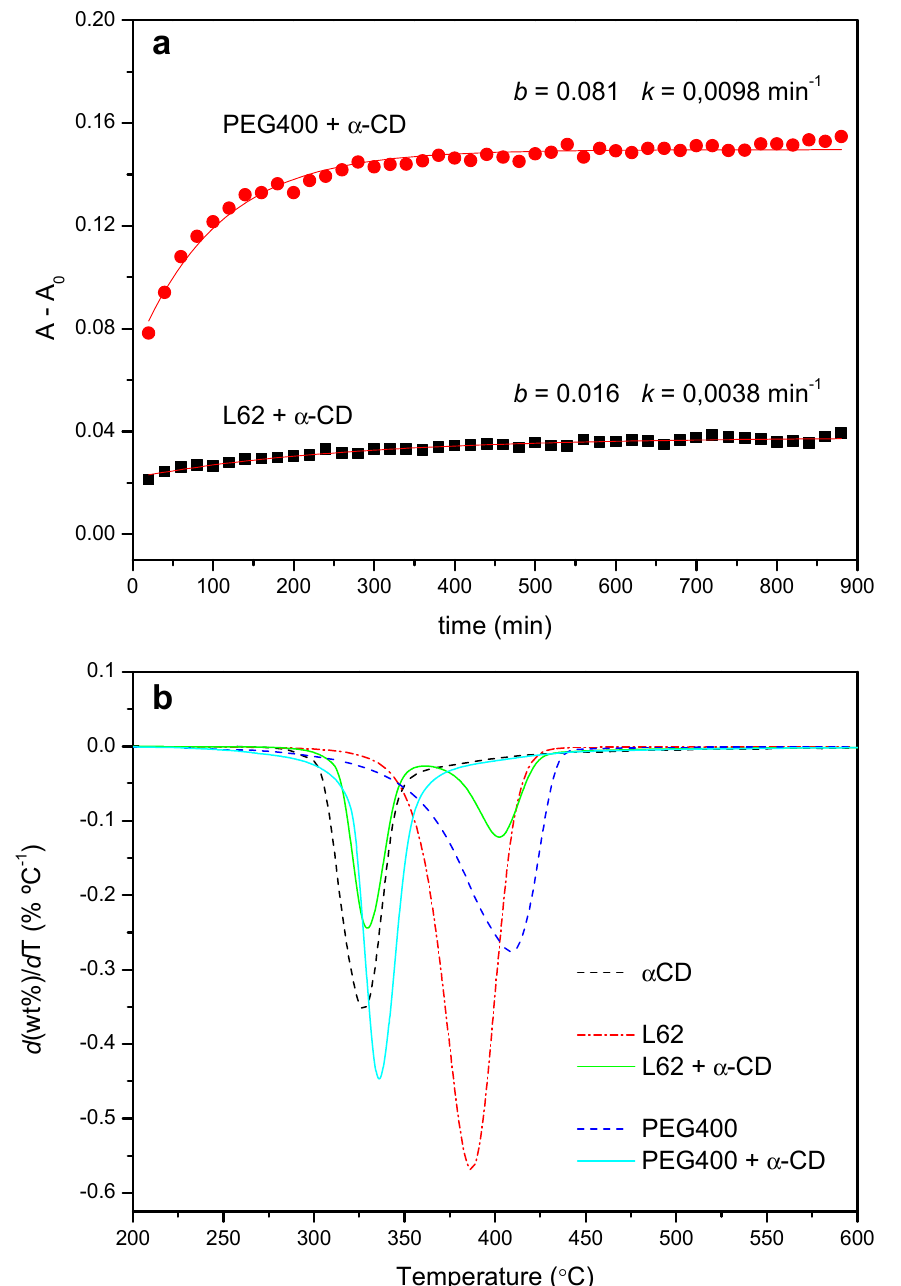
Figure 12. ( a ) Kinetic profiles for the reaction between L62 and α -CD (1:5, 50 °C) and PEG400 and α -CD (1:2, 55 °C). ( b ) DTG curves obtained from the PEG400 and L62 reactions with α -CD (1:2 and 1:5 feeds, respectively) after 24 h at 50 °C.